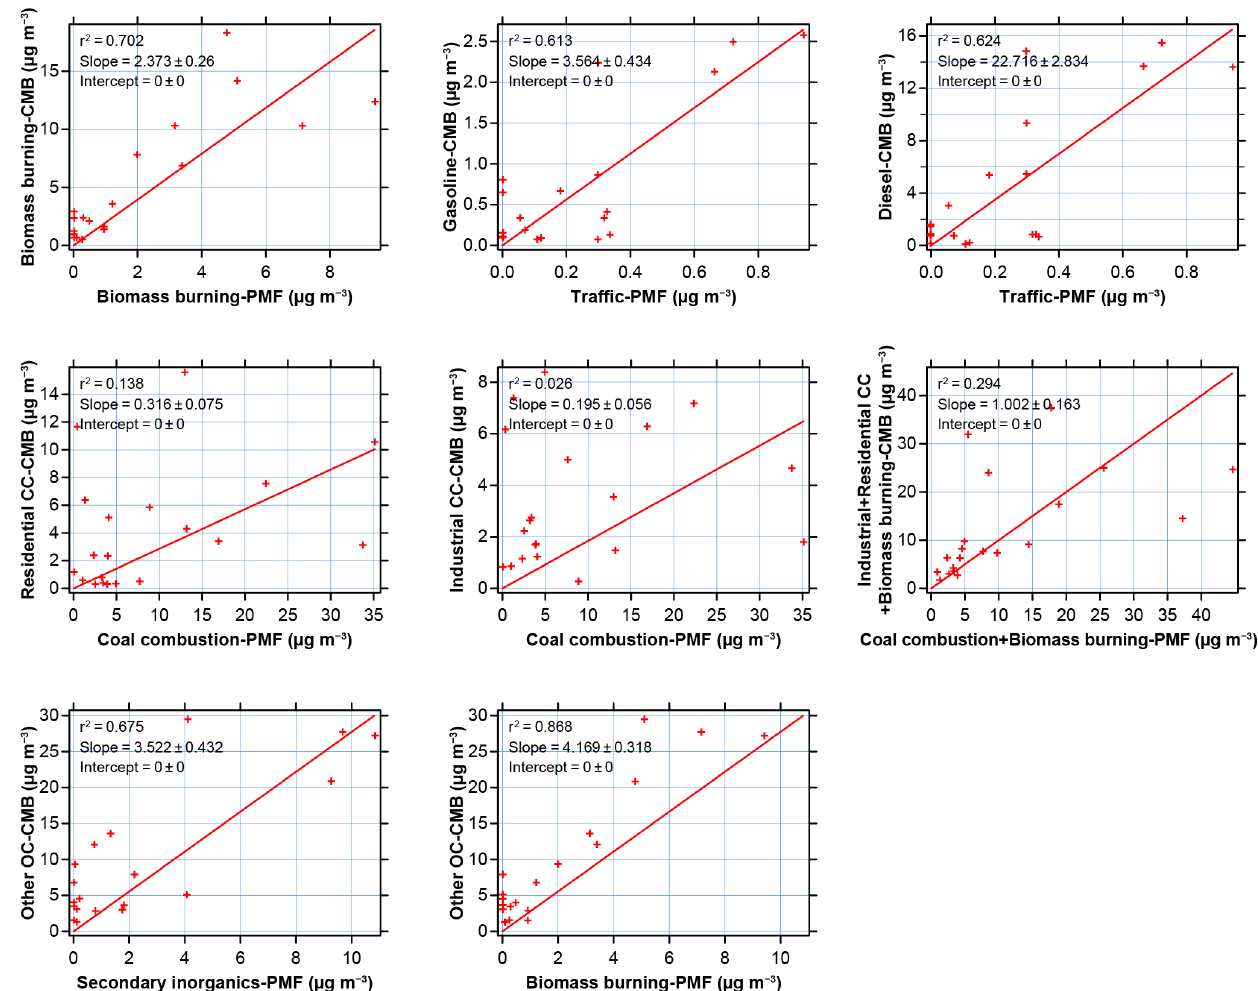
Figure 5. Correlations observed between PMF and CMB results at